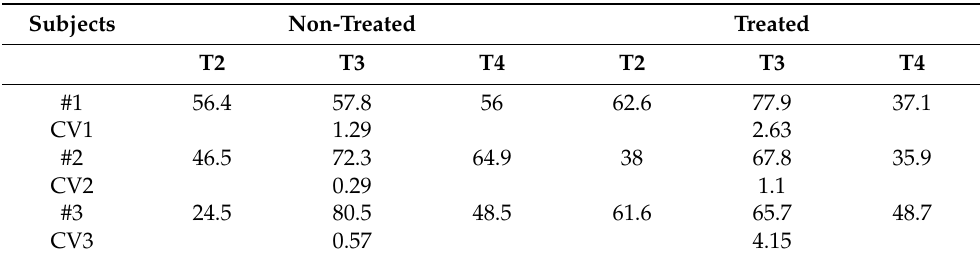
Figure 5. Impact of olive oil supplement on mature dendritic cells (DCs) (mDC: red line; pDC: blue line) during and after intense exercise (( A ). Non-treated group and ( B ). Treated group). The percentage of myeloid DCs (mDCs) increased in both treated and non-treated subjects from T2 to T3. The decrease in mDCs at T4 (24 h after the exercise) was greater for the treated subjects. Table 3. Coefficient of variation ( ∆ T3-T4/ ∆ T3-T2) evaluating recovery from exercise-induced inflam- mation in treated and non-treated